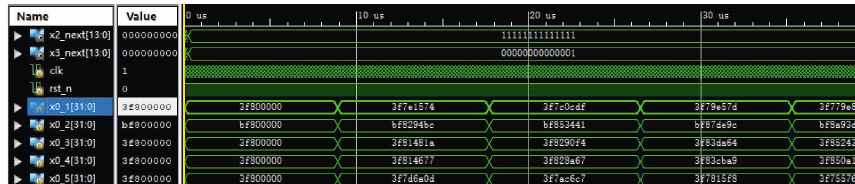
Figure 13: Simulation results of the FPGA-based HFWMS signal generator with the RK-4